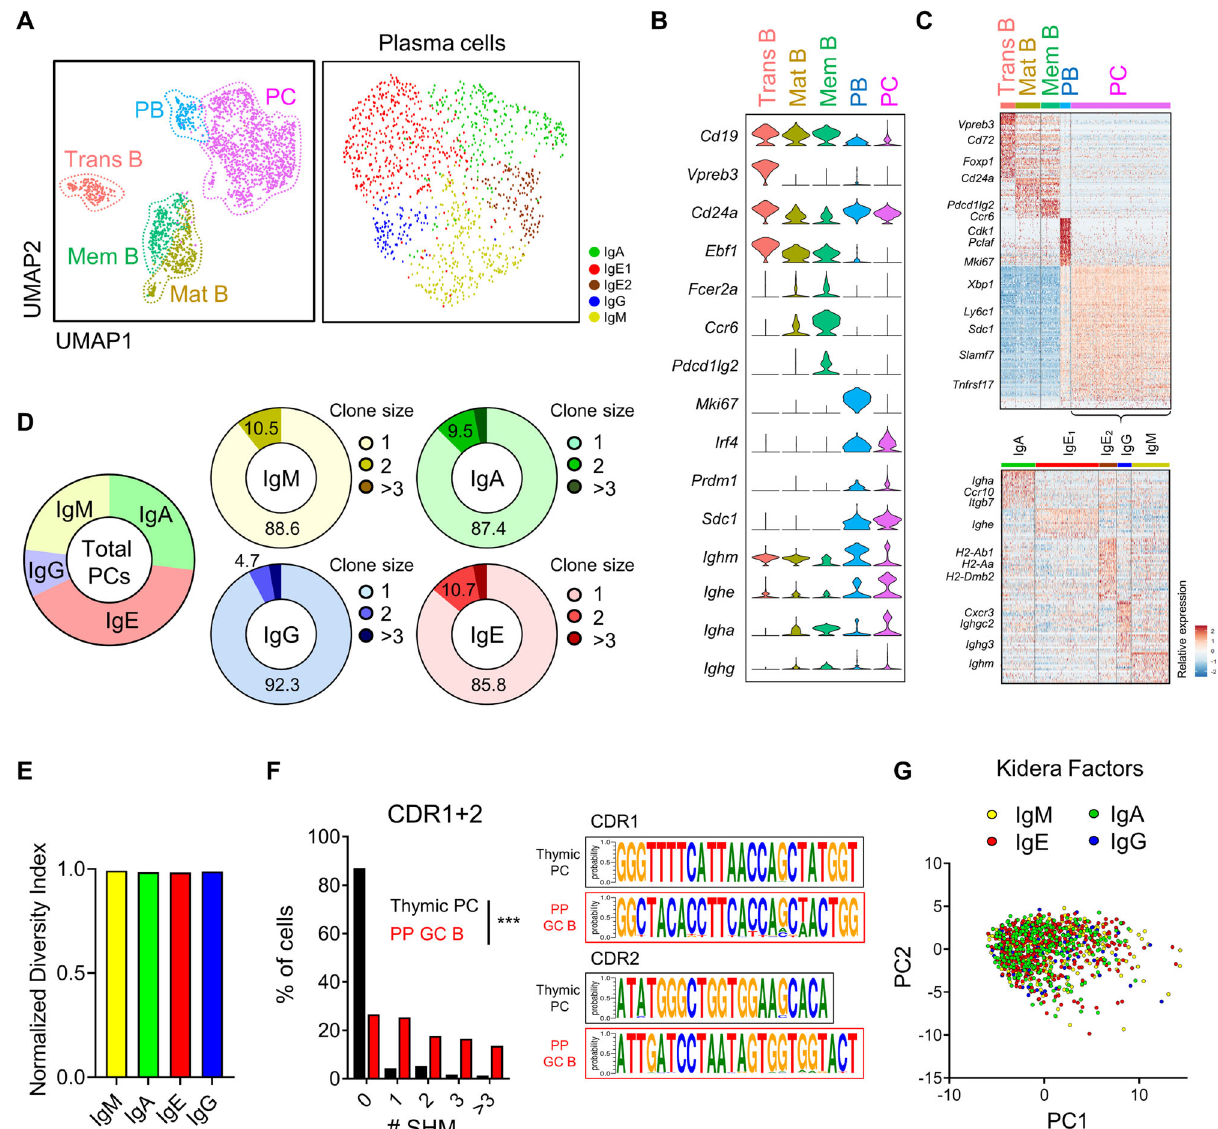
Fig. 4 scRNA-seq reveals the developmental landscape of thymic B cells. A Uniform manifold approximation and projection (UMAP) plot shows all cells (2053 cells, left) and PCs (1236 cells, right) from two pooled replicates. Each annotated B cell subtype and isotypes of PCs were labeled with indicated colors. B Violin plots show the expression levels of B cell subtype marker genes. C Heat-map shows the relative expression of differentially expressed genes of each annotated B cell subtype in all cells (top) and each isotype cluster in PCs (bottom). D Pie charts show the percentage of cells belonging to each isotype in PB/PCs (left) and the percentage of clone size per isotype (right). E Bar plot shows the Shannon equitability indices of clonotypes across isotypes in PB/PCs. F Graph shows the percentage of cells with different numbers of SHMs in the CDR1 and CDR2 sequences of heavy chains between thymic PCs and PP GC B cells (left). Relative CDR1 and CDR2 sequences for the most abundant V gene of the heavy chain were shown by using WebLogo (right). G PCA plot shows cells colored by different isotypes using Kidera Factors of heavy chain CDR3 regions. Two-sided chi-squared test was used in ( F ). *** p < 0.001. Trans B Transitional B cells; Mat B Mature B cells; mem B Memory B cells; PB Plasmablast; PC Plasma cell; SHM Somatic hypermutation; PP Peyer ’ s patch; GC B Germinal center B